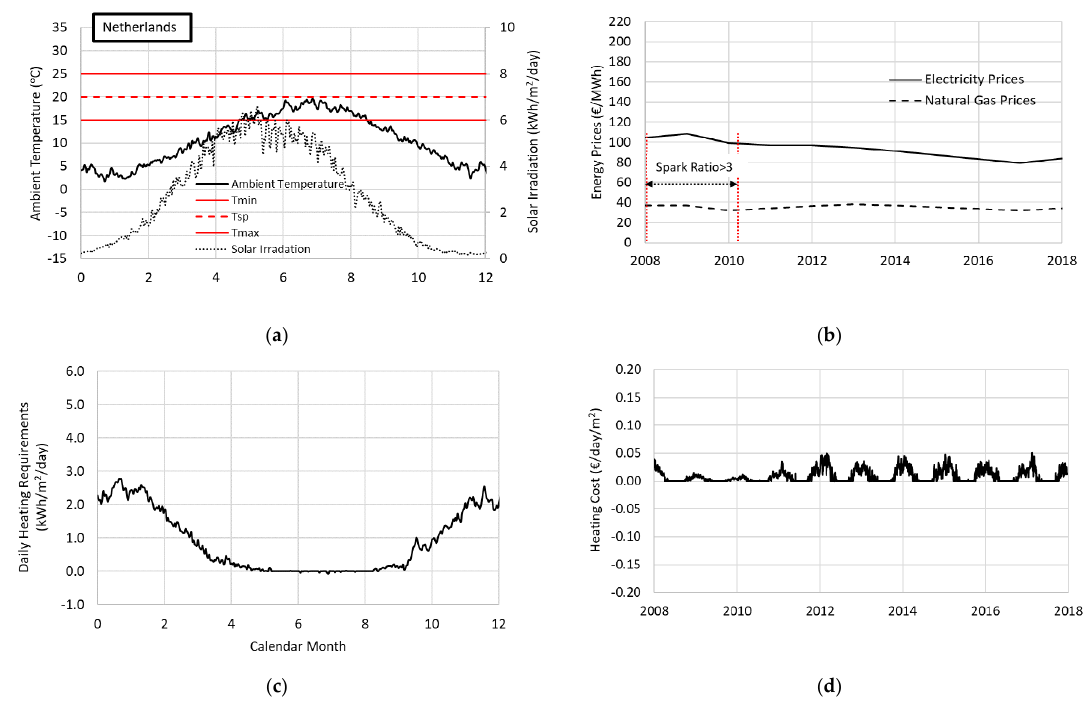
Figure 9. Evolution of seasonal greenhouse energy cost in the Netherlands during the 2008–2018 period. Summarized results of ( a ) climatic conditions, ( b ) evolution of energy prices, ( c ) energy requirements, and ( d ) evolution of energy cost.